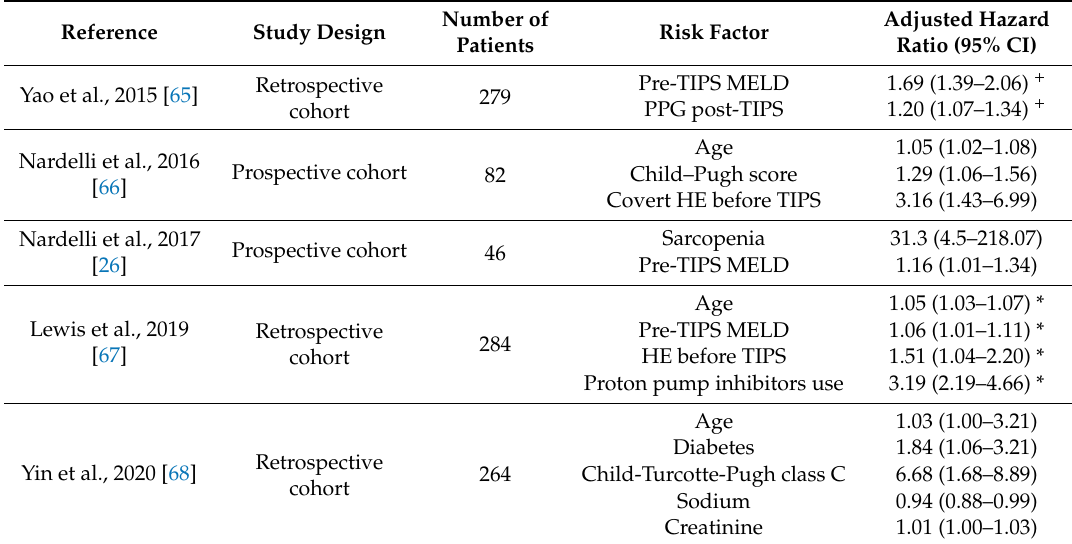
Table 3. Recent relevant publications identifying specific risk factors of post-TIPS